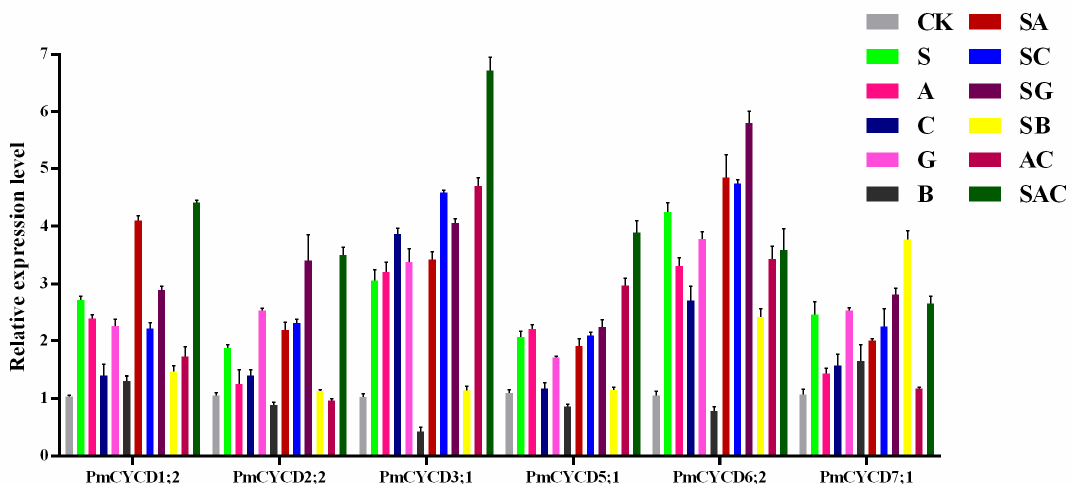
Figure 6. The expression levels of PmCYCDs genes were analyzed in roots under different treatments including NAA, 6-BA, GA3, ABA, and sucrose.